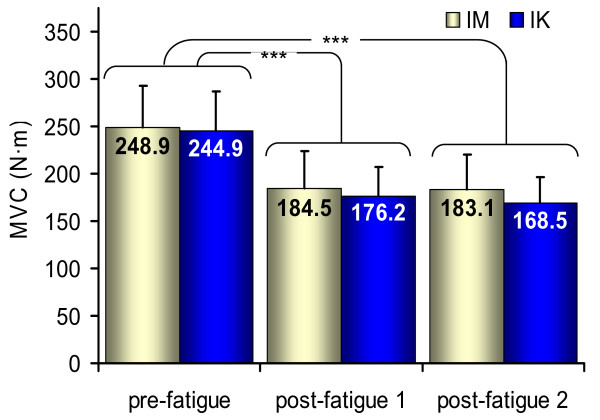
Changes in torque output. Mean and standard deviation of MVCIM torque output for each fatiguing exercise. Torque significantly decreased with fatigue (*** p < 0.001), similarly for both types of exercise.